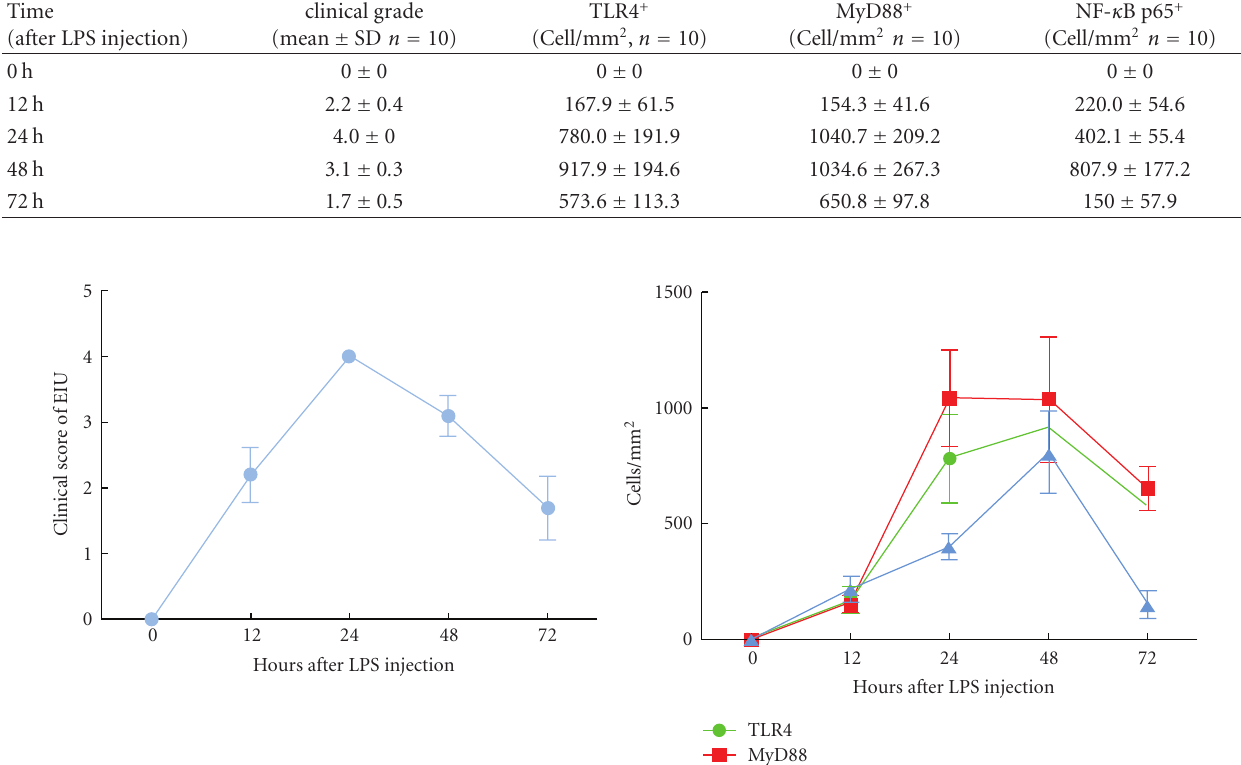
was expressed in iris-ciliary body after LPS